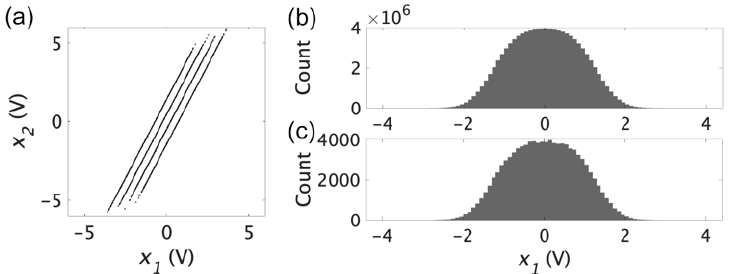
Figure 4. ( a ) 16QAM signal mixed with Gaussian noise; ( b ) histogram of the original mixed signal; ( c ) histogram of the under sampled signal.